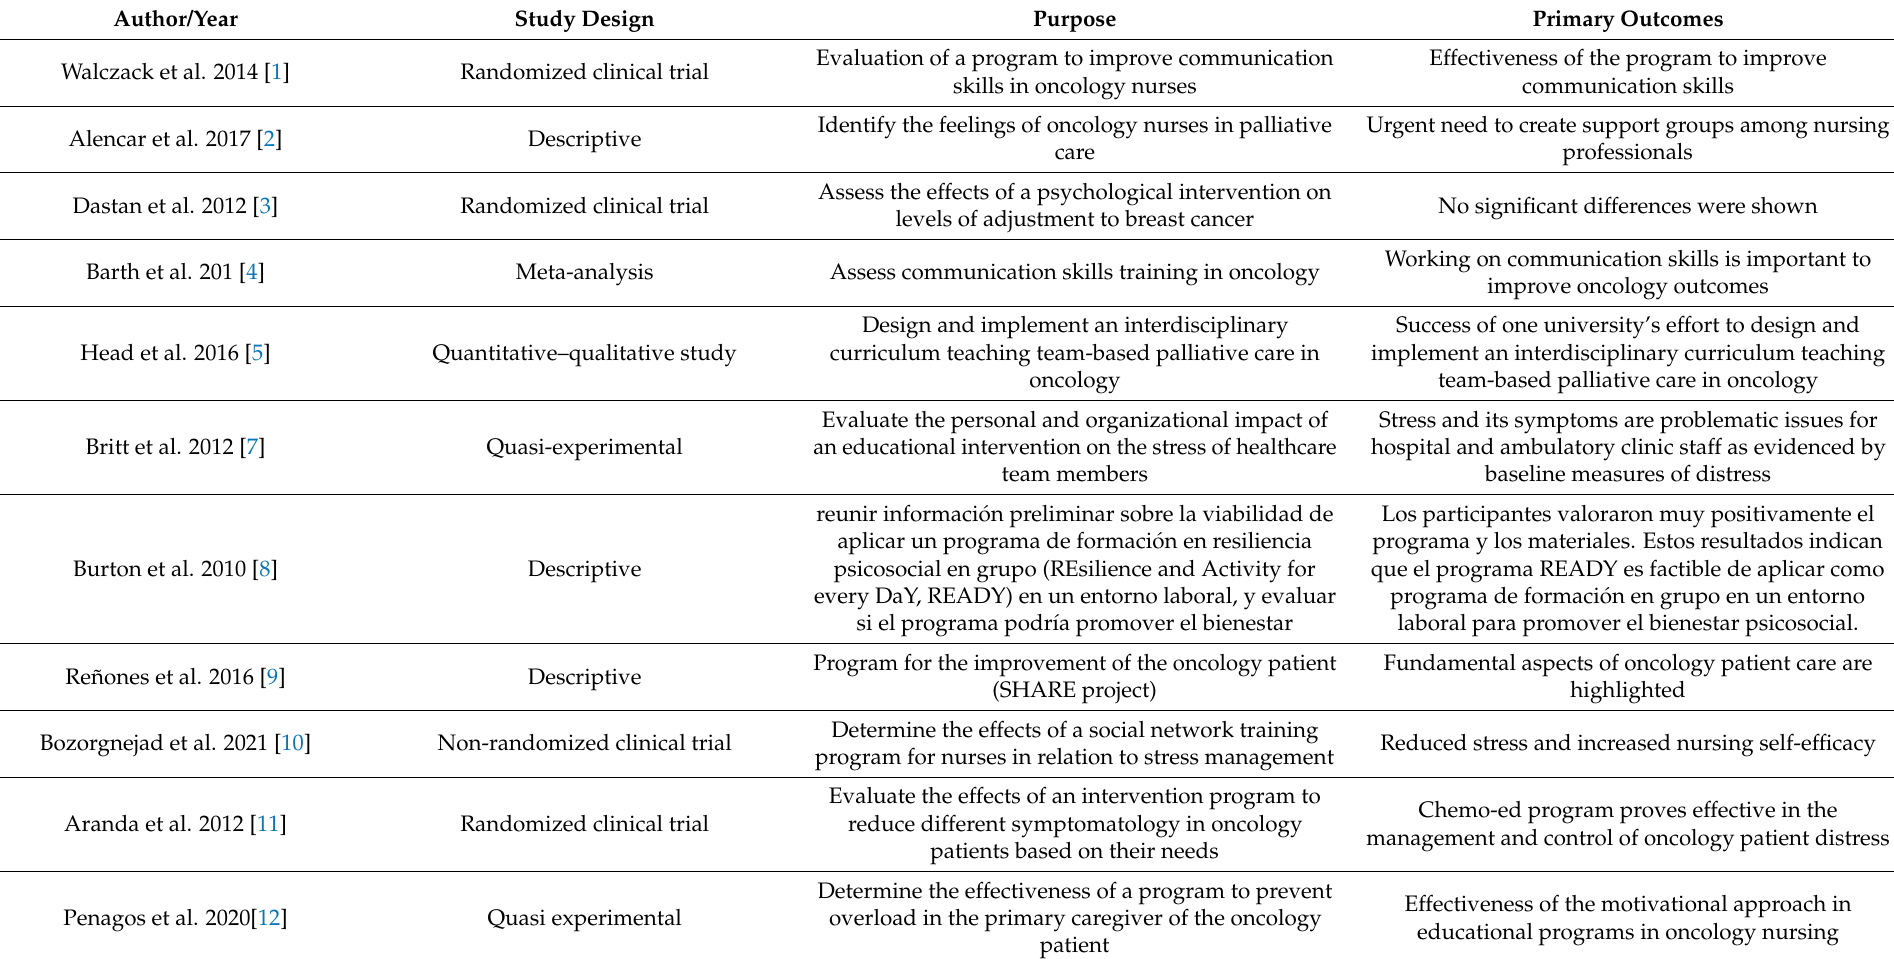
Table 4. Overview of included